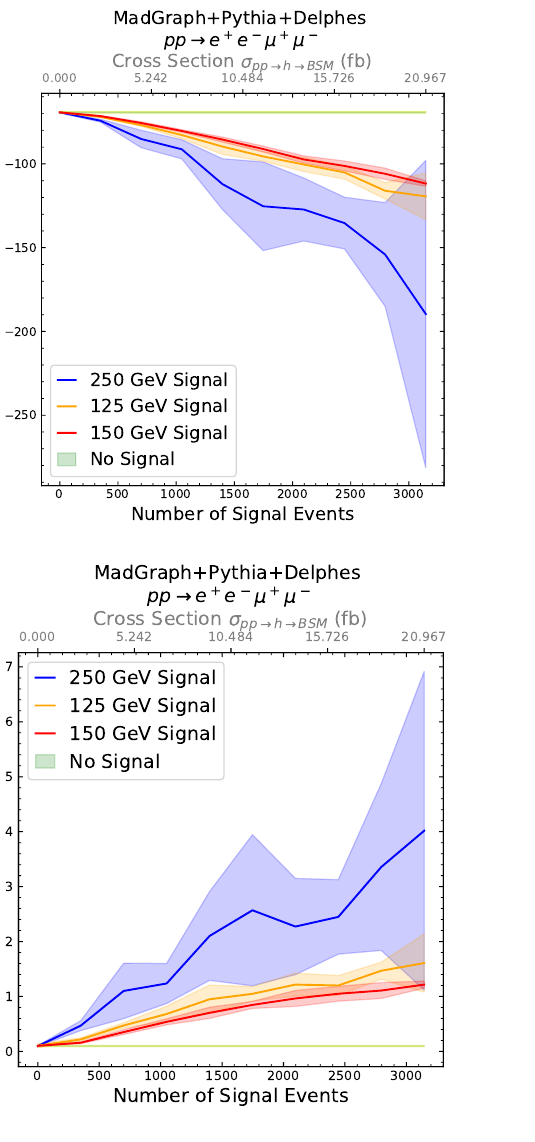
Figure 2 . MLC Loss. The average loss (top left), average score (top right), score standard deviation (lower left), and maximum score (lower right) when using the MLC loss as a function of the number of injected signals. The green (yellow) band corresponds to the 1 σ (2 σ ) region of the background-only hypothesis. The bands for each signal correspond to the standard deviation across 10 independent signal injections. The upper axis provides the injected cross section, where the number of background events corresponds to 150 fb − 1